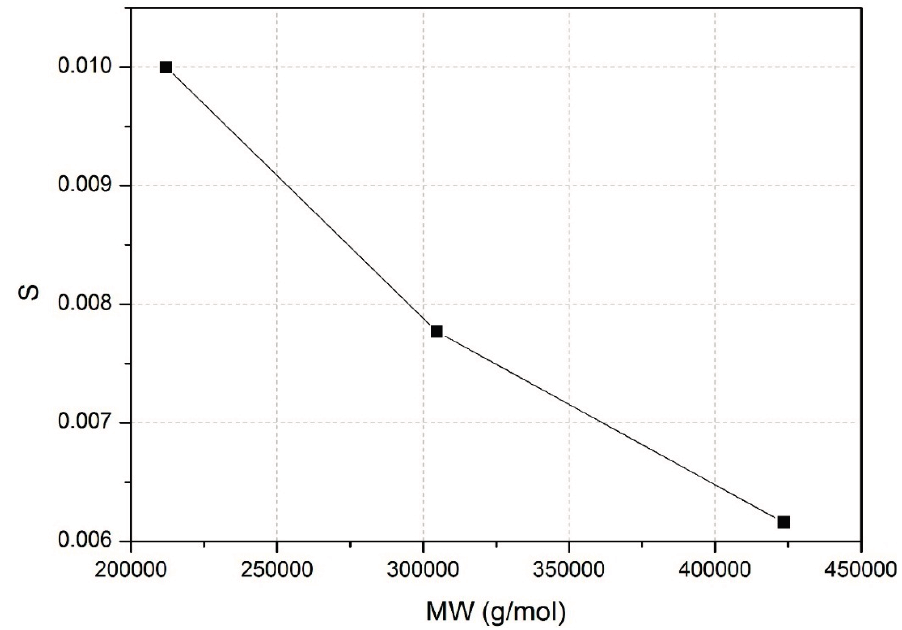
Figure 6. Influence of the molar mass on the maximum of the slope S as a function of polymer concentration for A4C, A15C and A4M, respectively, at 20 °C. All of the maximums are located at 2.8